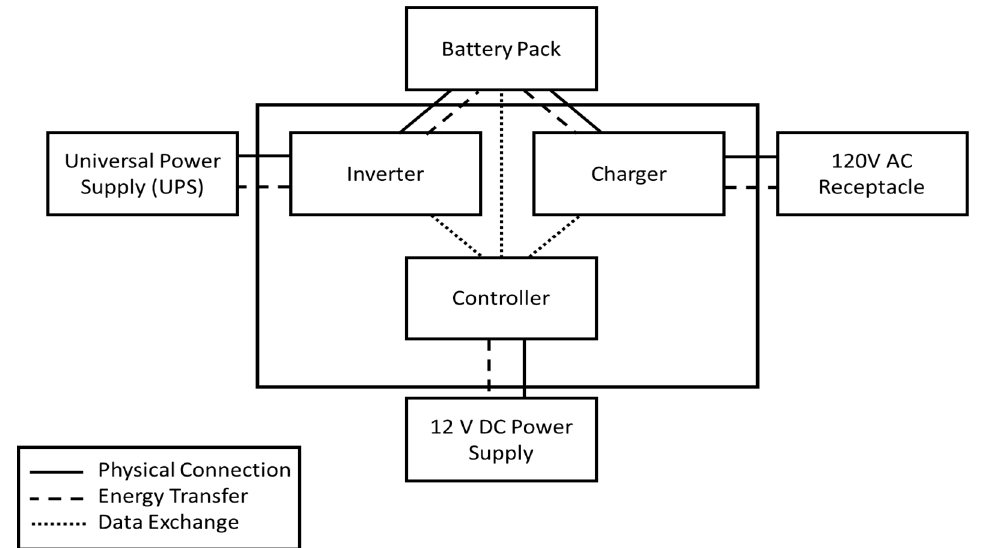
Figure 5. FMEA boundary diagram.